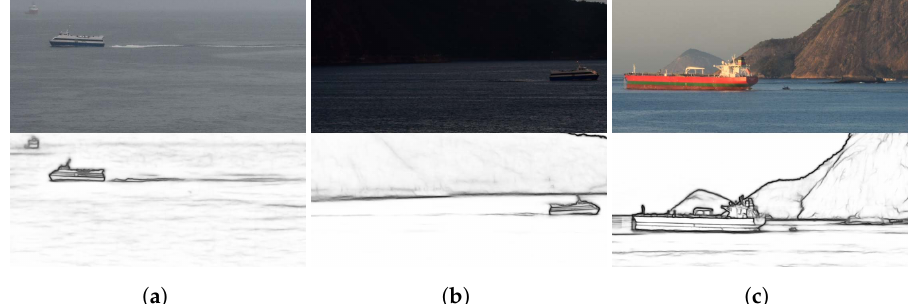
Figure 7. Cropped versions of some of the images in which our approach could not detect wave arms that had at least two well-defined troughs in the edge